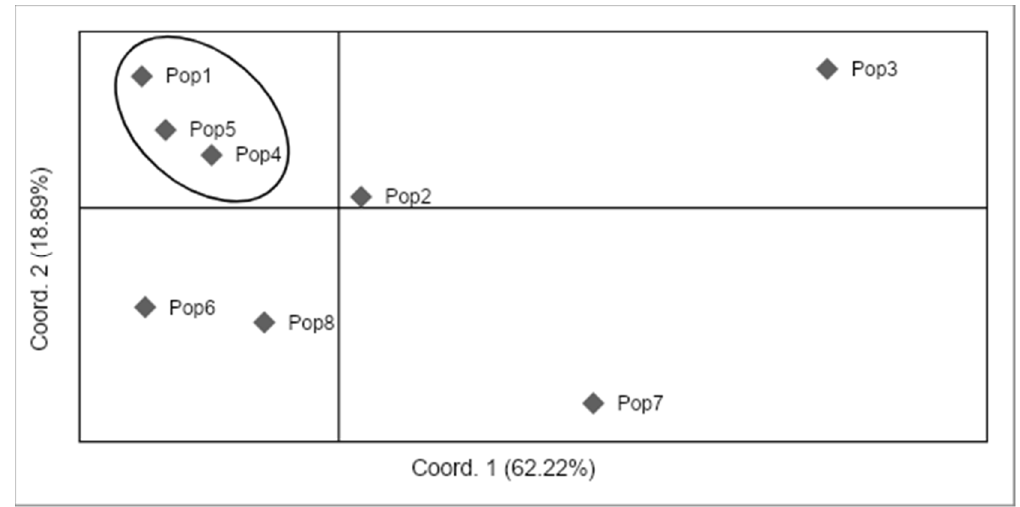
Figure 4. Principal Coordinate Analysis (PCoA) plot based on pairwise genetic distances of F ST(ENA) values. Population numbers according to Table 2.